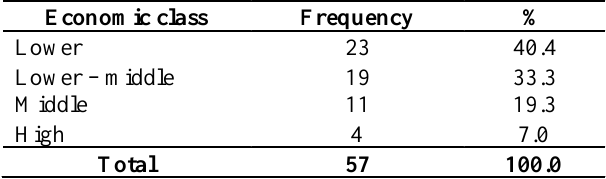
Table IV : Economic Class of Sample study population Economic class